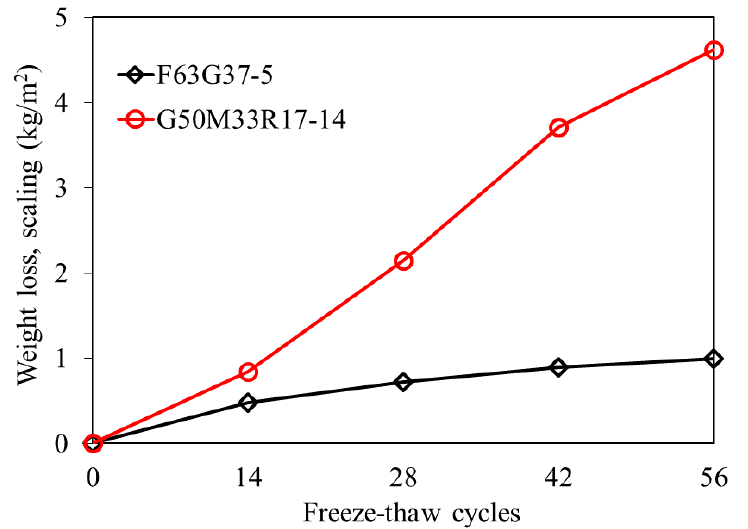
Figure 6. Mean scaling during freeze-thaw